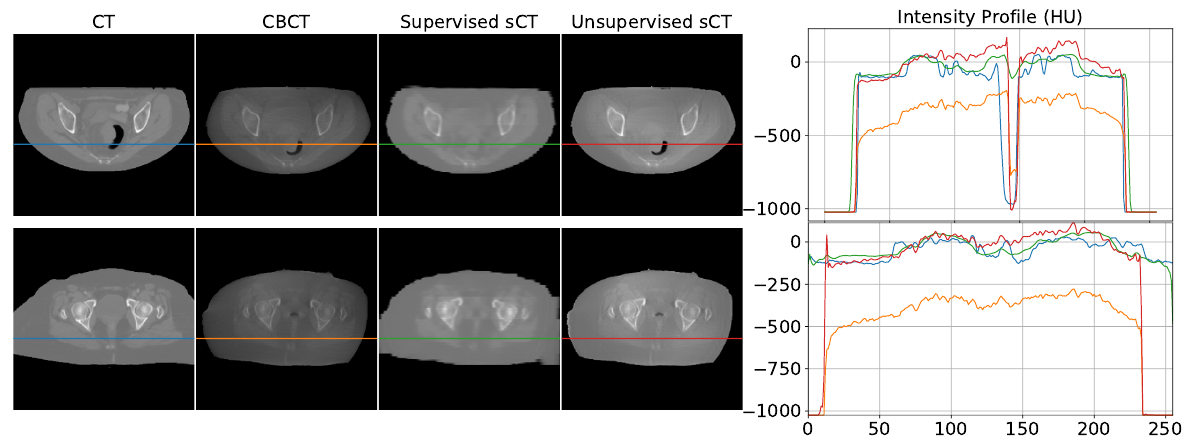
Figure 8. Examples of non-linearity of CBCT scans. Air gap introduced a notch in the intensity profile ( top ). Beam hardening is visible as a convex shape in the orange curve of both examples ( bottom ). Images are displayed with Window = 2000, Level =